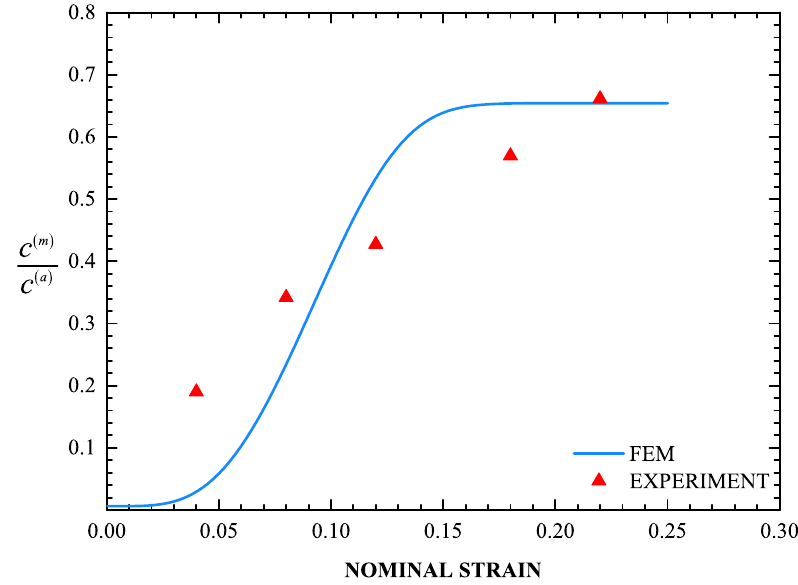
Figure 12. Calculated f - ε curve together with the experimental data (red